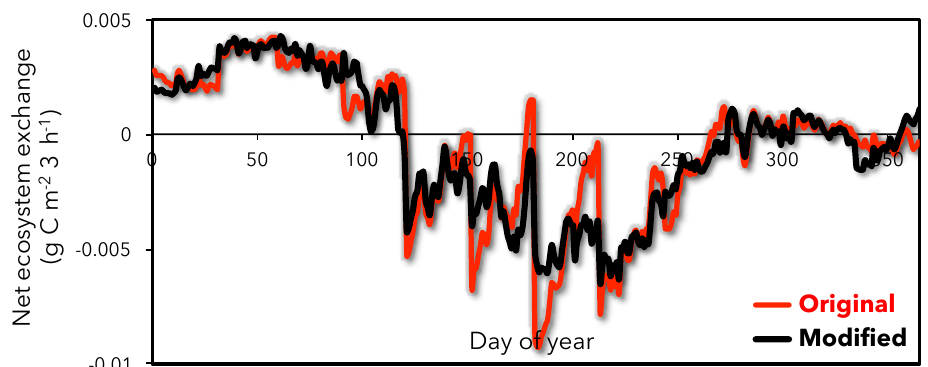
Figure 1. The original downscaling approach of Olsen and Randerson (2004) used monthly fixed values, which led to a “stair-stepping” behavior between months (red). This was eliminated by using a 30-day moving window and interpolating monthly input values to 3-hourly time steps (black). Example shown for Lund–Potsdam–Jena (LPJ) model global mean year 2005.